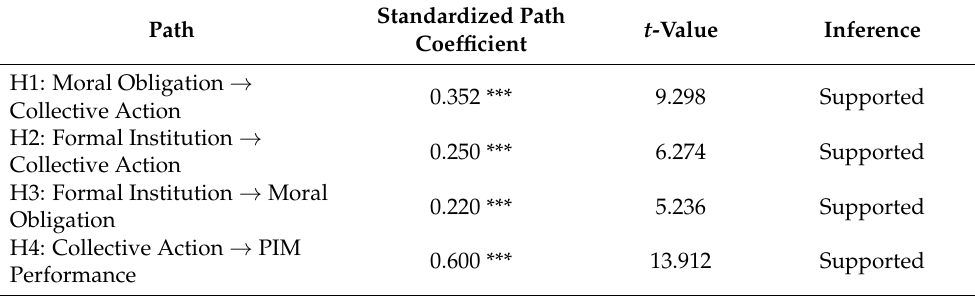
Table 3. Results of the structural model.